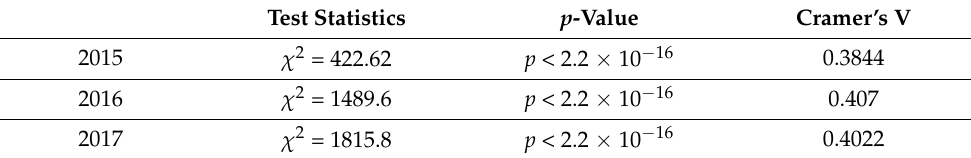
Table 7. Test results: The relationship between gender and the type of